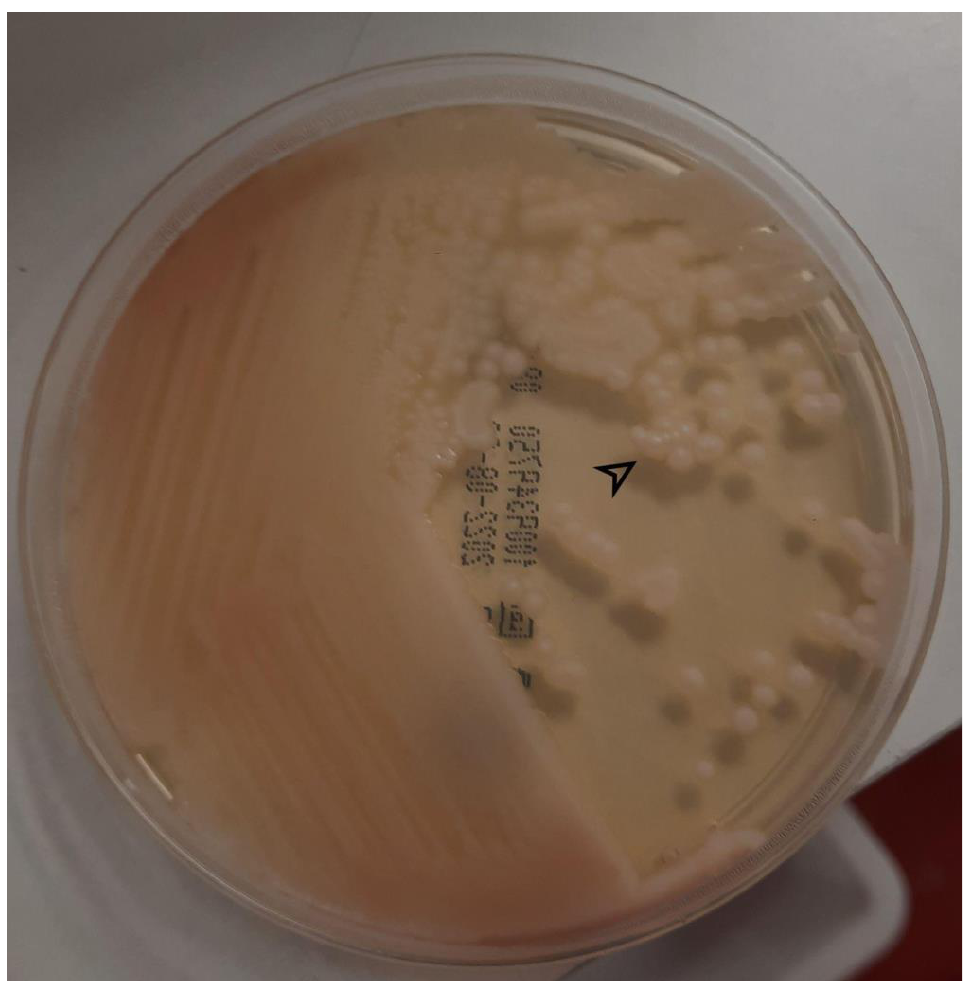
Figure 1. C. lipolytica colonies (arrow) growing on Sabouraud agar.